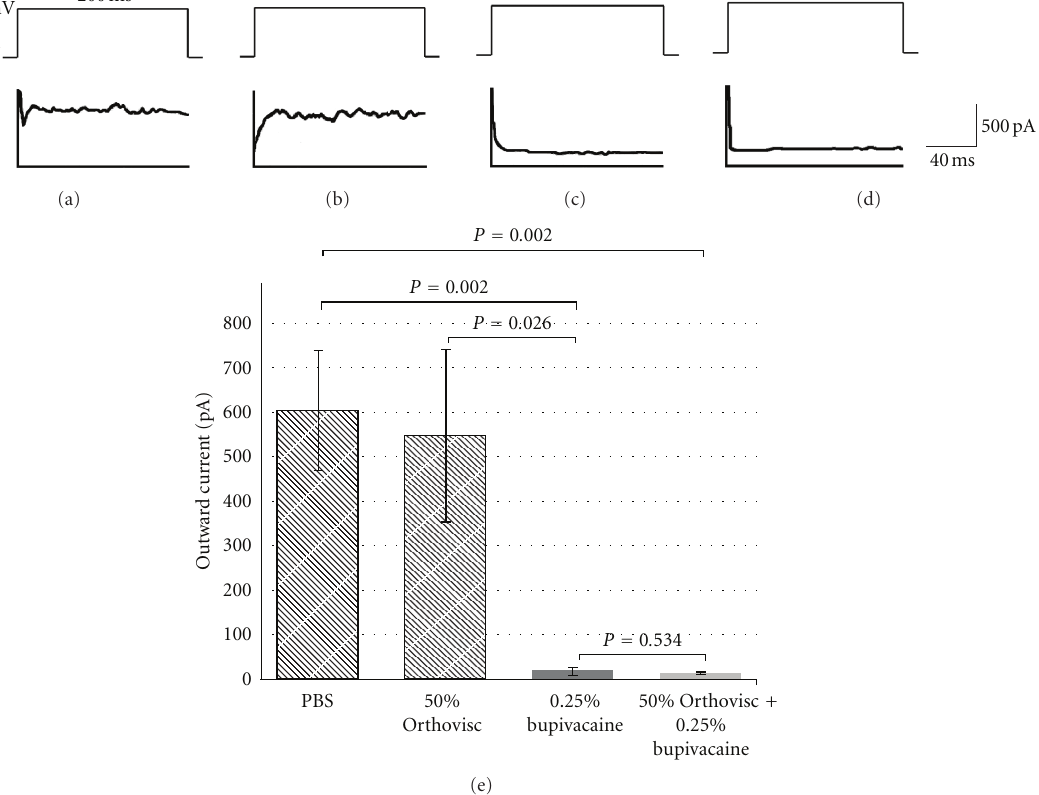
Figure 2: Representative whole cell patch clamp recordings showing outward currents elicited by depolarization at 150 mV with holding for 200 ms. Bovine articular chondrocytes were treated with PBS (a), 7.5mg/mL hyaluronan (b), 0.25% bupivacaine (c), and a mixture of 7.5mg/mL hyaluronan and 0.25% bupivacaine (d). (e) Means and standard errors (error bars) of the outward currents recorded in five chondrocytes ( n = 5). P values were obtained by Student’s t -test